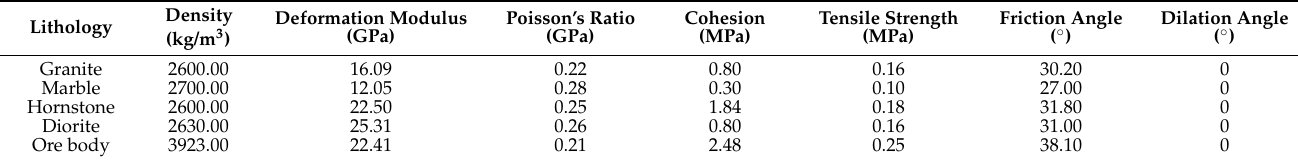
Table 3. Geometric parameters and distributions of the